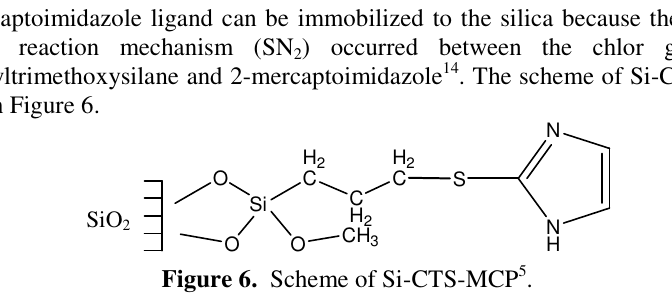
Figure 6. Scheme of Si-CTS-MCP 5